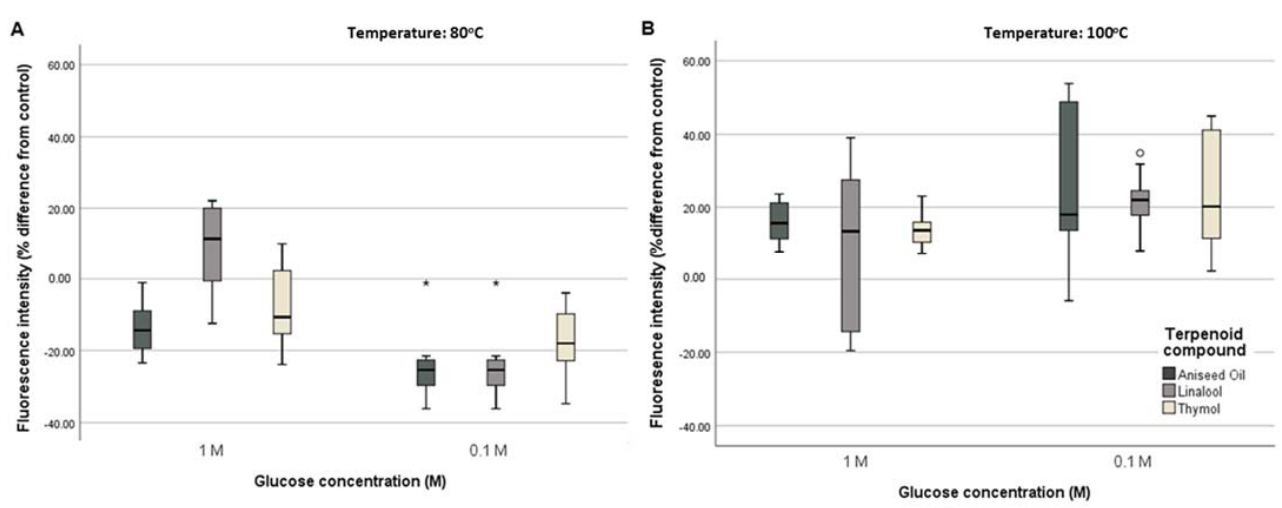
Figure 8. The effect of terpenoid compounds on fluorescence intensity at λ exc = 370 nm, λ emm = 440 nm in heated glucose/lysine solutions at 0.1 M and 1 M glucose at pH 7.2 and ( A ) 80 °C and ( B ) 100 °C. Symbols (*,**, °) outside the boxplots indicate outliers.